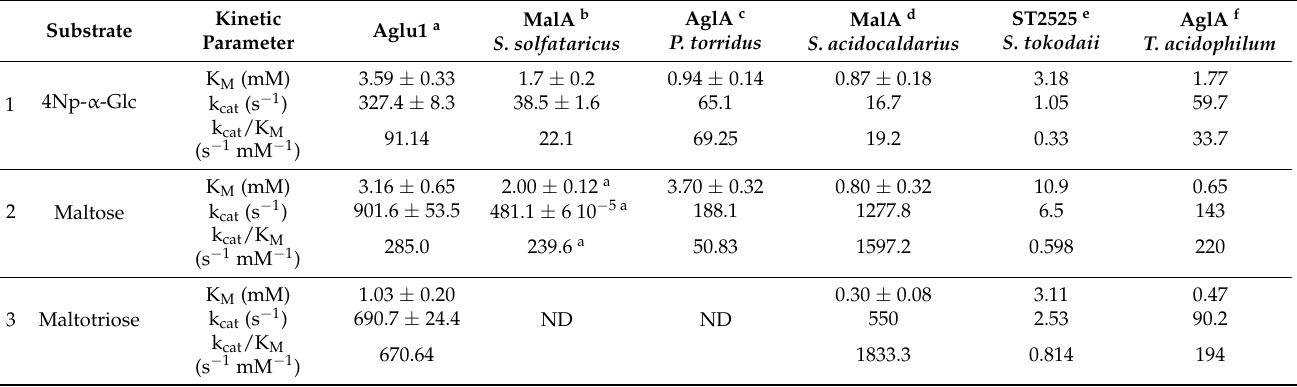
Table 2. Comparison of the steady-state kinetic constants of Aglu1 with all archaeal characterized GH31. a (This study), b [56], c [37], d [36], e [35], f [38]. Kinetic Parameters of Aglu1, MalA from S. solfataricus and AglA from P. torridus were measured at 85 ◦ C, while MalA from S. acidocaldarius , ST2525 from S. tokodaii and AglA from T. acidophilum at 95 ◦ C, 80 ◦ C and 80 ◦ C, respectively. ND: not